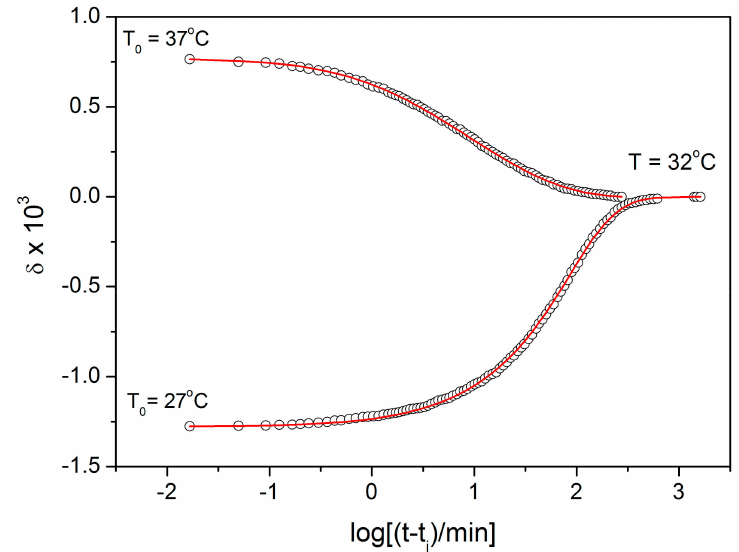
Figure 2. The volume change of Se glass subjected to a temperature down-jump and up-jump ± 5 ◦ C. Points correspond to experimental data obtained by dilatometry. Full lines were calculated for the Tool–Narayanaswamy–Moynihan (TNM) model (parameters in